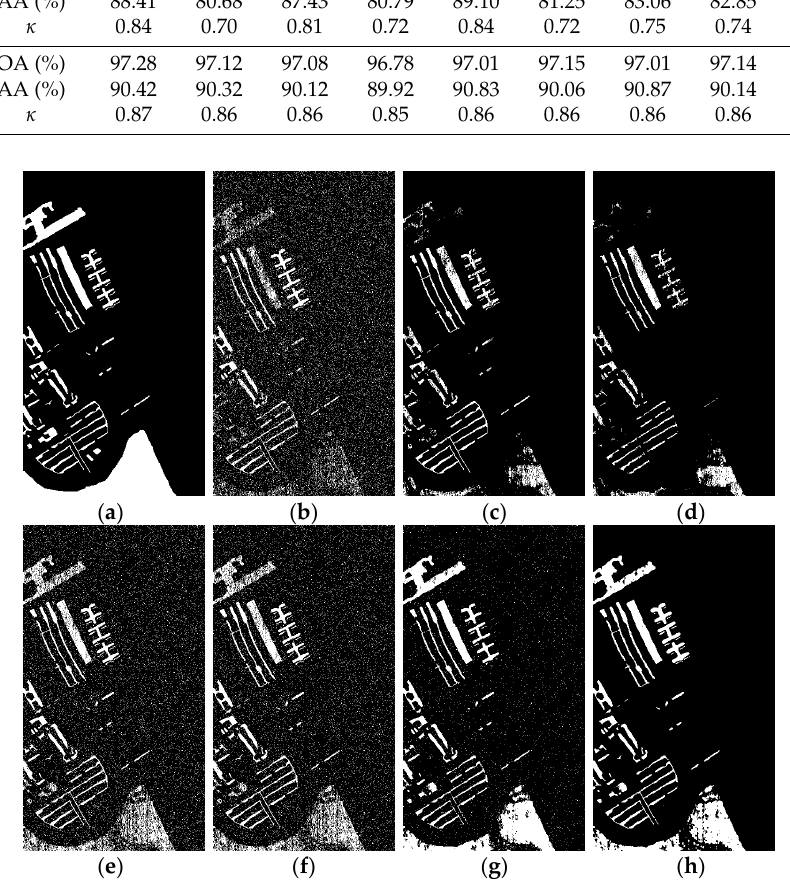
Figure 6. Label maps, including: ( a ) ground truth map; and change detection results yielded by: ( b ) K-Means (OA = 84.93%); ( c ) SAM + K-Means (OA = 67.20%); ( d ) ASCD + K-Means (OA = 69.61%); ( e ) PCA + K-Means (OA = 90.65%); ( f ) LRSD + K-Means (OA = 91.23%); ( g ) LRSD_TV + K-Means (OA = 94.07%); and ( h ) LRSD_SS + K-Means (OA = 97.10%), tested on one randomly selected set of bitemporal HSI of Data 3. The changed are labeled by “1” and colored in white, while the unchanged are labeled by “0” and colored in black. OA is short for overall